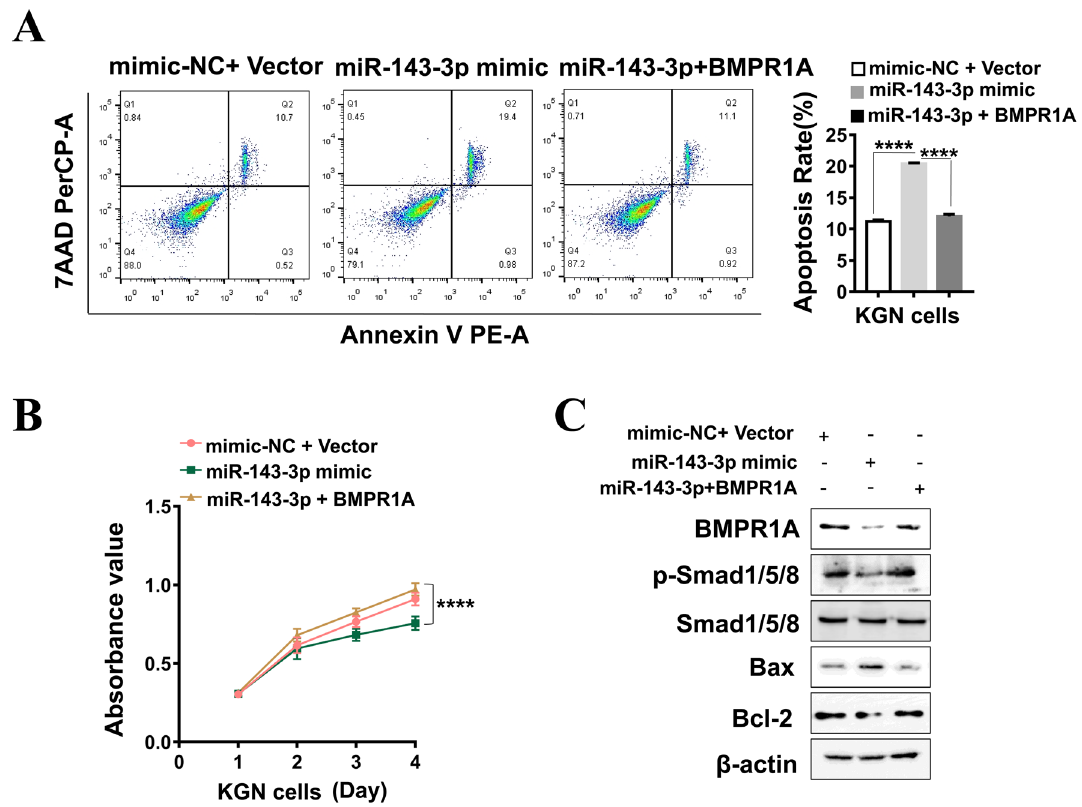
Figure 6. miR-143-3p promotes cell apoptosis and suppresses cell proliferation by inhibiting the BMPR1A/ Smad1/5/8 signaling pathway. (A) Flow cytometry detection of apoptosis after KGN cells were cotreated with BMPR1A-expressing plasmid and miR-143-3p mimic. (B) CCK8 analysis of cell viability after KGN cells were cotreated with BMPR1A-expressing plasmid and miR-143-3p mimic. (C) Western blotting analysis showing the expression of BMPR1A, Smad1/5/8, p-Smad1/5/8 and apoptosis-related proteins in KGN cells treated with miR- 143-3p mimic and/or BMPR1A-expressing plasmid. Original blots/gels are presented in Supplementary Fig. S7. ns no significance, * P < 0.05, ** P < 0.01, *** P < 0.001. All results are presented as the mean ±